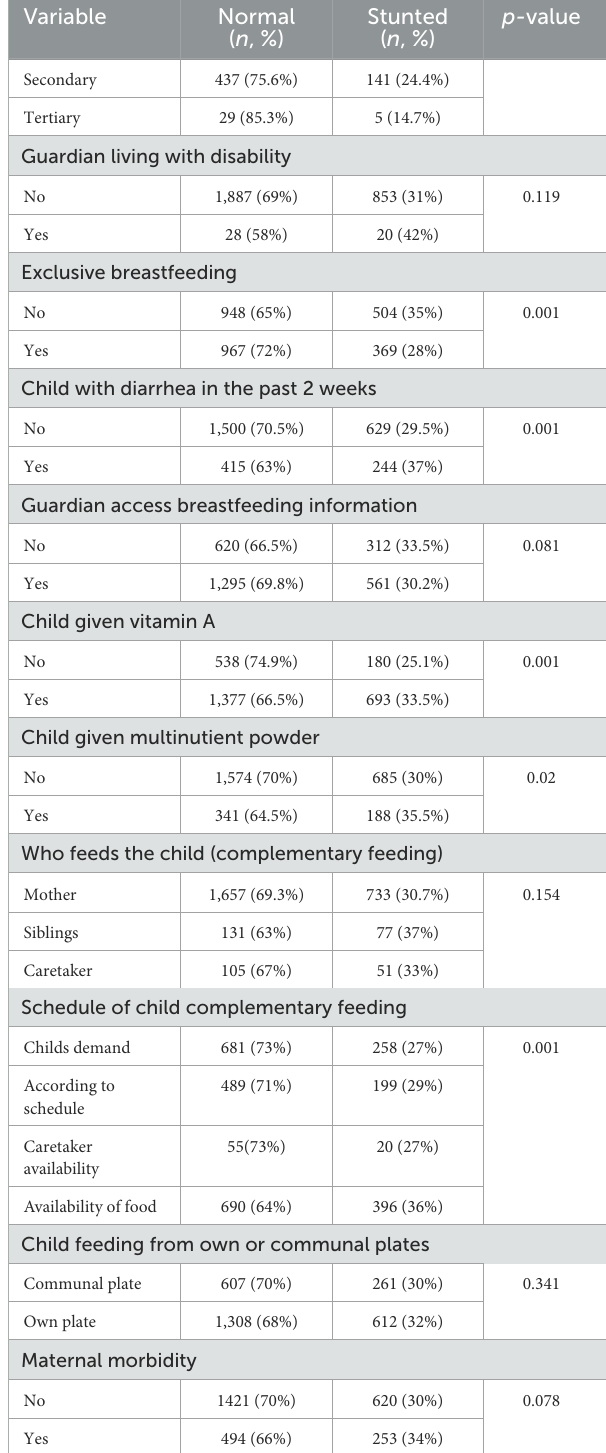
TABLE 1 Prevalence of childhood stunting at various individual (child/maternal and household) level